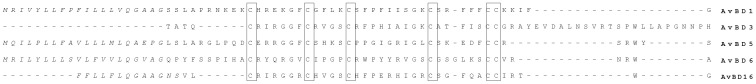
Deduced amino acid sequence alignment of the five novel avian β-defensins (AvBDs) from the duck.Signal sequences of the Apl_AvBDs are italic. The conserved six cysteines (C) are framed. Dashes indicate no identical or conserved residues observed.